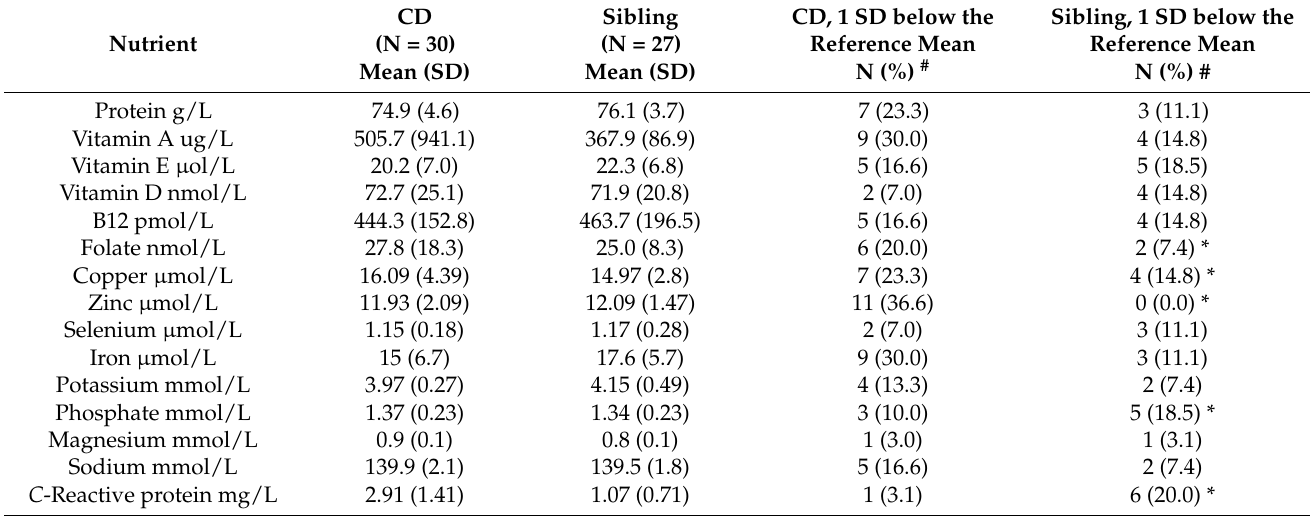
Table 4. The blood micronutrient status of the study